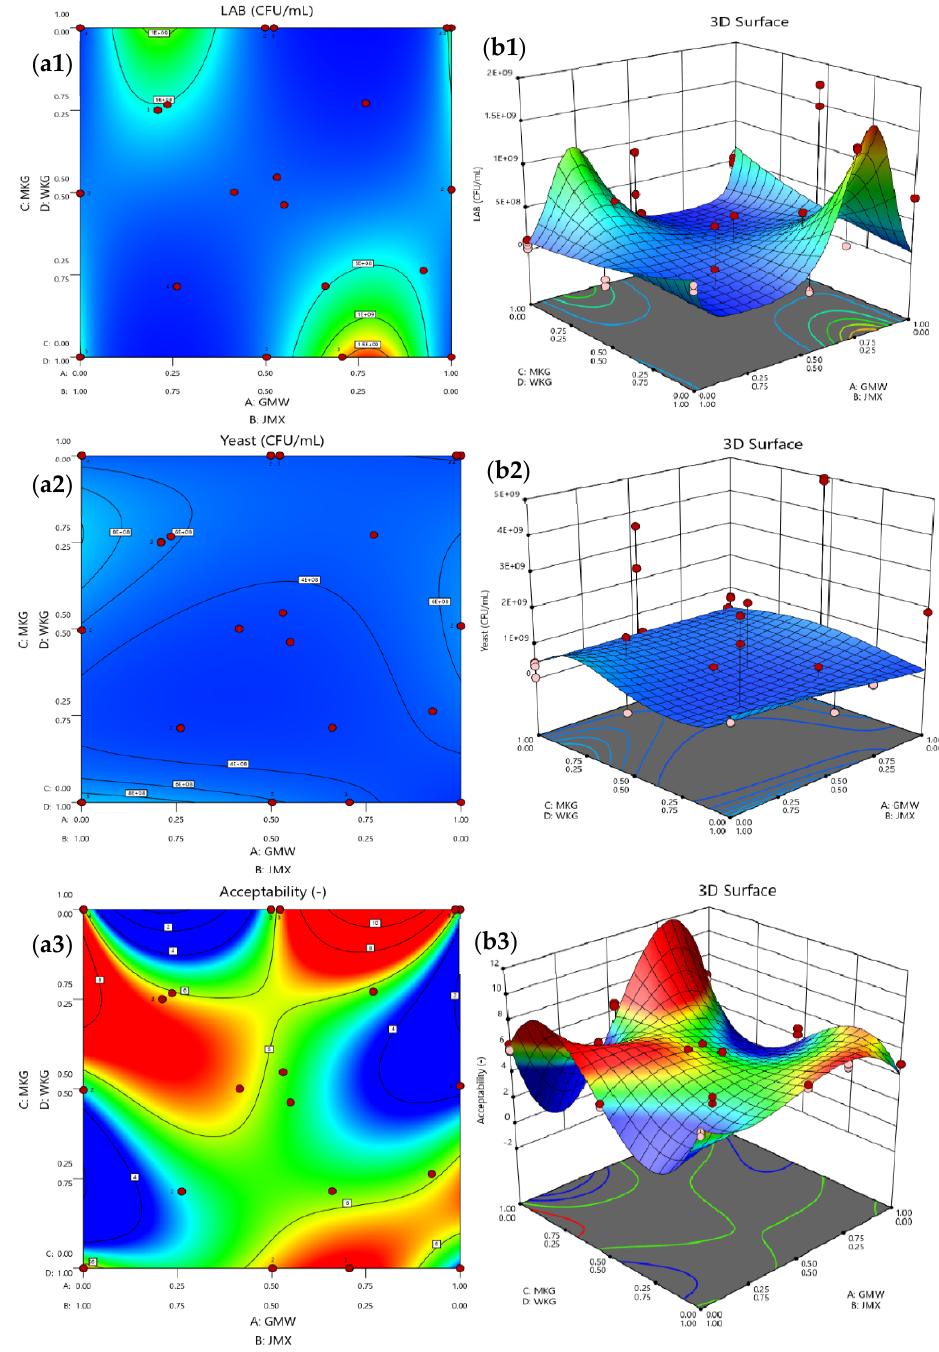
Figure 2. Contour ( a1 – a3 ) and 3D ( b1 – b3 ) plots for the models of the responses expressed by equations from (1) to (3) for LAB concentration ( ˆ y L , a1 , b1 , upper), yeast concentration ( ˆ y Y , a2 , b2 , middle), and overall acceptability ( ˆ y Ac , a3 , b3 , lower),